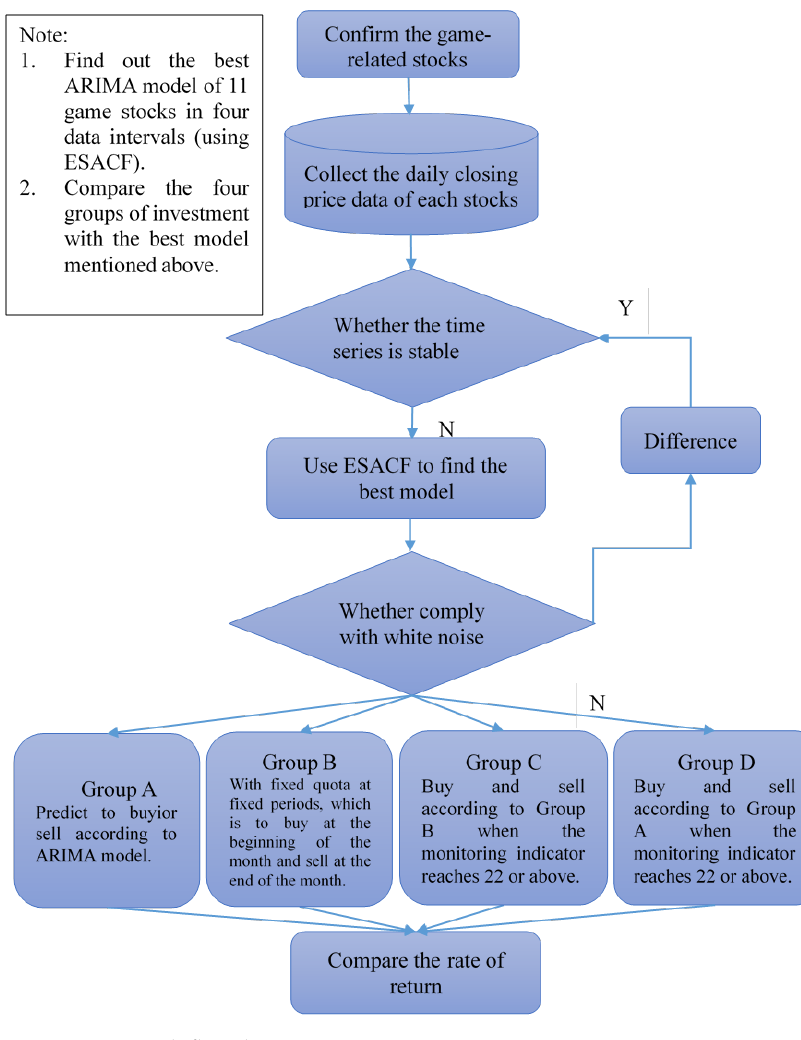
Figure 1. Research flowchart.